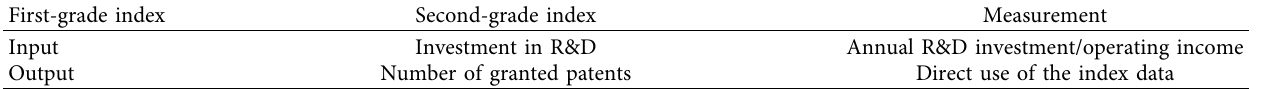
Table 1: Evaluation index system of the innovation efficiency of the IM